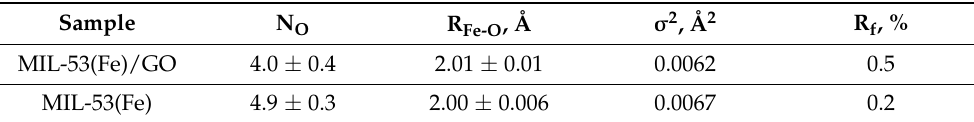
Table 3. Results of single-sphere EXAFS simulations at the K-edge of Fe for samples MIL-53(Fe)/GO and MIL-53(Fe). Here, R Fe-O is the Fe-O interatomic distance, N O is the coordination number, σ 2 —is the Debye-Waller factor, R f is the quadratic incoherence. Fourier transform range k = 2–12–Å-1, modeling range R = 1–2